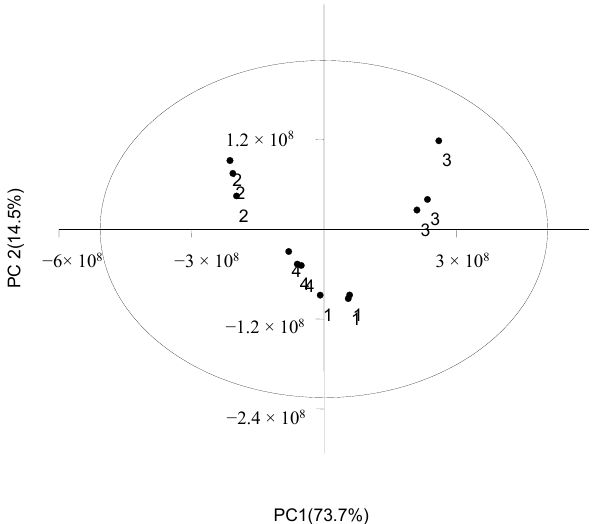
Figure 2. PCA analysis of root exudates of two peanut varieties. 1: A. correntina − 30d. 2: A. correntina − 60d. 3: GH85 − 30d. 4: GH85 − 60d.